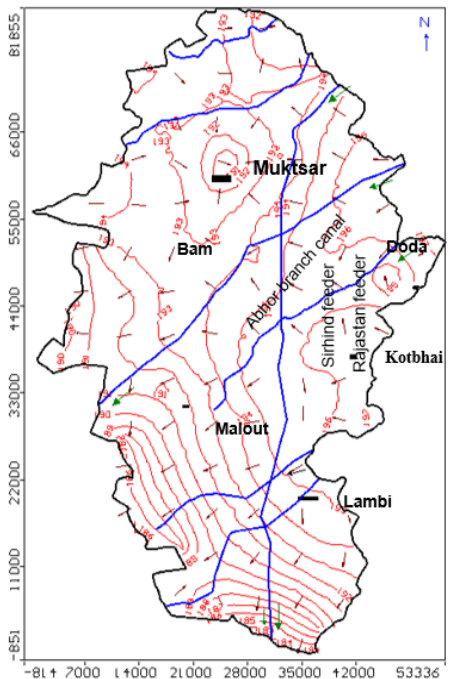
Figure 4. Computed groundwater contours and velocity in the Muktsar district ( x - and y -axes are in m).